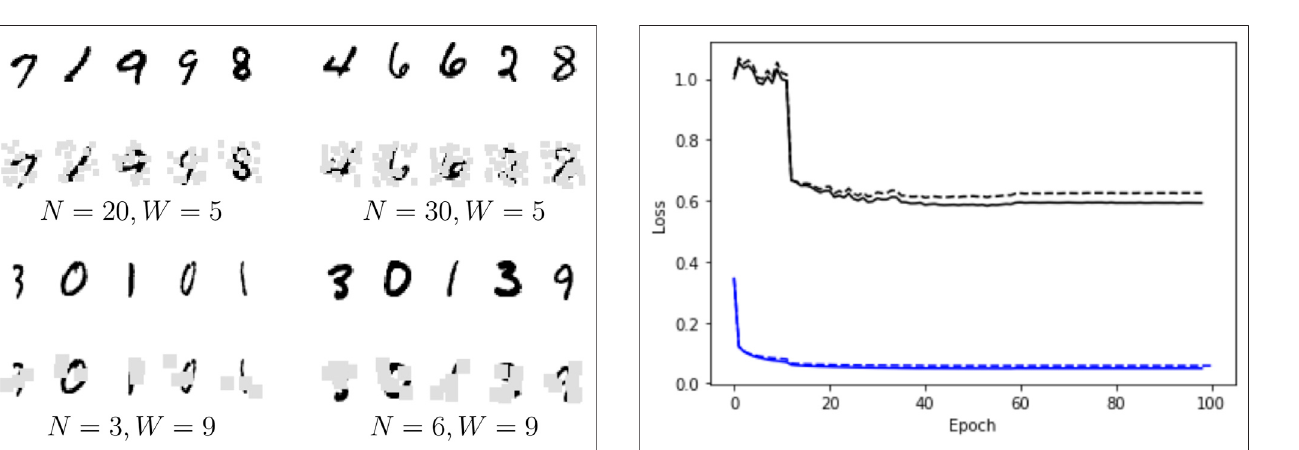
FIGURE 2 | Illustration of the considered MNIST dataset with the selected missing data patterns: We randomly remove data from N W × W square areas.